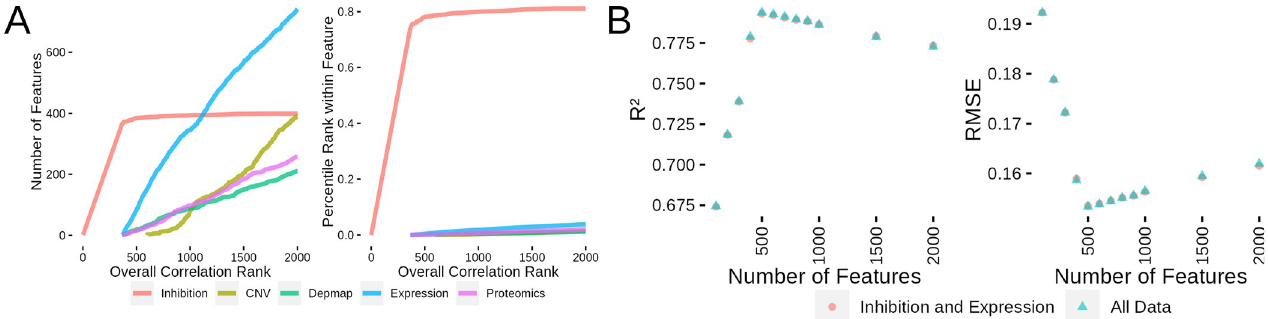
Fig 5. Regression Models using Additional Data Sets Don’t Dramatically Outperform inhibition and Expression Models. (A) Plot showing the order features are selected for model inclusion (left) and the percentile rank within each feature class as features are selected for inclusion in the model (right). (B) Comparison between models built with inhibition data and expression or all available data sets by R 2 (left) and by RMSE (right).